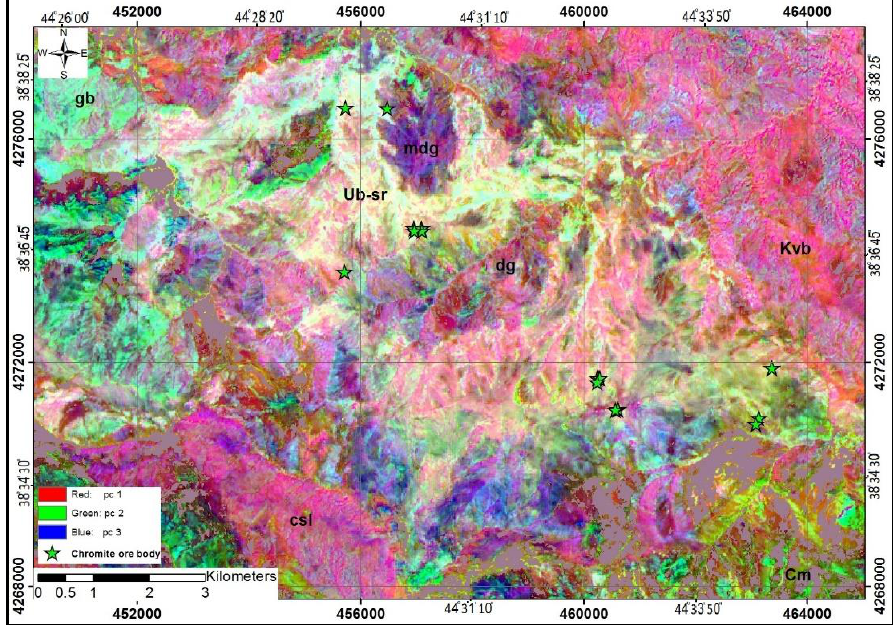
Figure 12. The RGB image of PC1, PC2, and PC3 of PCA bands in the study area: Ub-sr—serpentinized ultrabasic; mdg—microdiorite gabbro; dg—diorite gabbro; Cm—conglomerate; Kvb—basalt pillow lava; csl—shale and conglomerate.